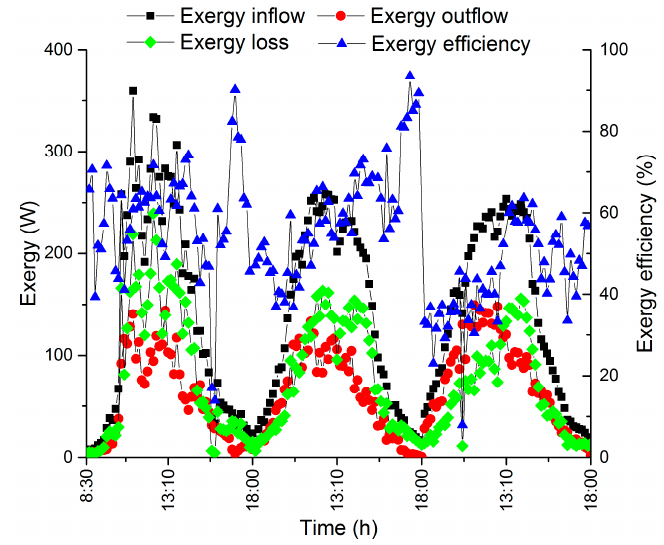
Figure 15. The variation of exergy flow, loss and efficiency.